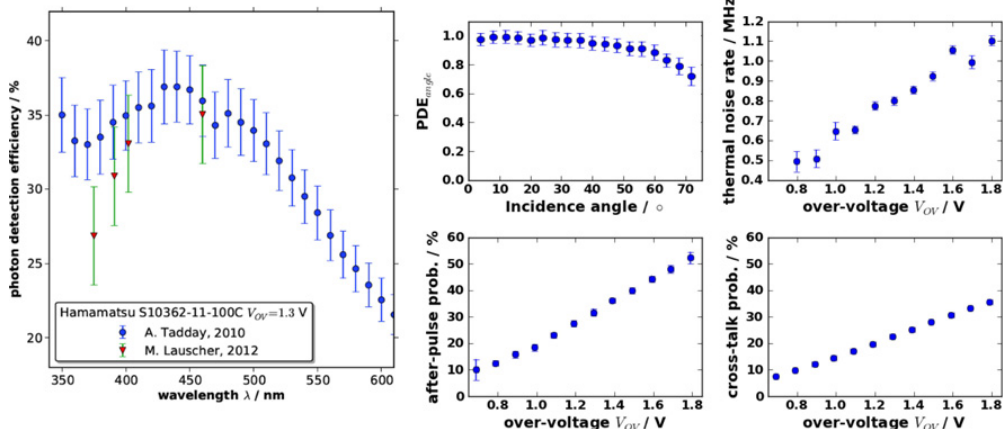
Figure 2. Left : photon detection efficiency (PDE) of an SiPM with 1 × 1mm 2 detection area and 100 (cid:1) m cell pitch (Hamamatsu S10362-11-100C) as a function of the wavelength. Triangles show data from our laboratory [6] in comparison to earlier measurements [7] (circles). The over-voltage is V OV = 1.3V. A parametrization of [7] is used in our telescope simulations. Right : Top-left - PDE as a function of the incident angle of light relative to an angle of 0 ◦ . Remaining plots - Thermal noise rate, optical crosstalk and afterpulse probabilities as functions of the over-voltage V ov . The over-voltage is the difference between the bias voltage of the SiPM V bias and the breakdown voltage V bd above which cell breakdowns can occur: V bias = V bd + V ov . Ambient temperature T = (25.5 ± 0.1) ◦ C. The results are for the S10362-11-100C type. - Systematic uncertainties are not shown.